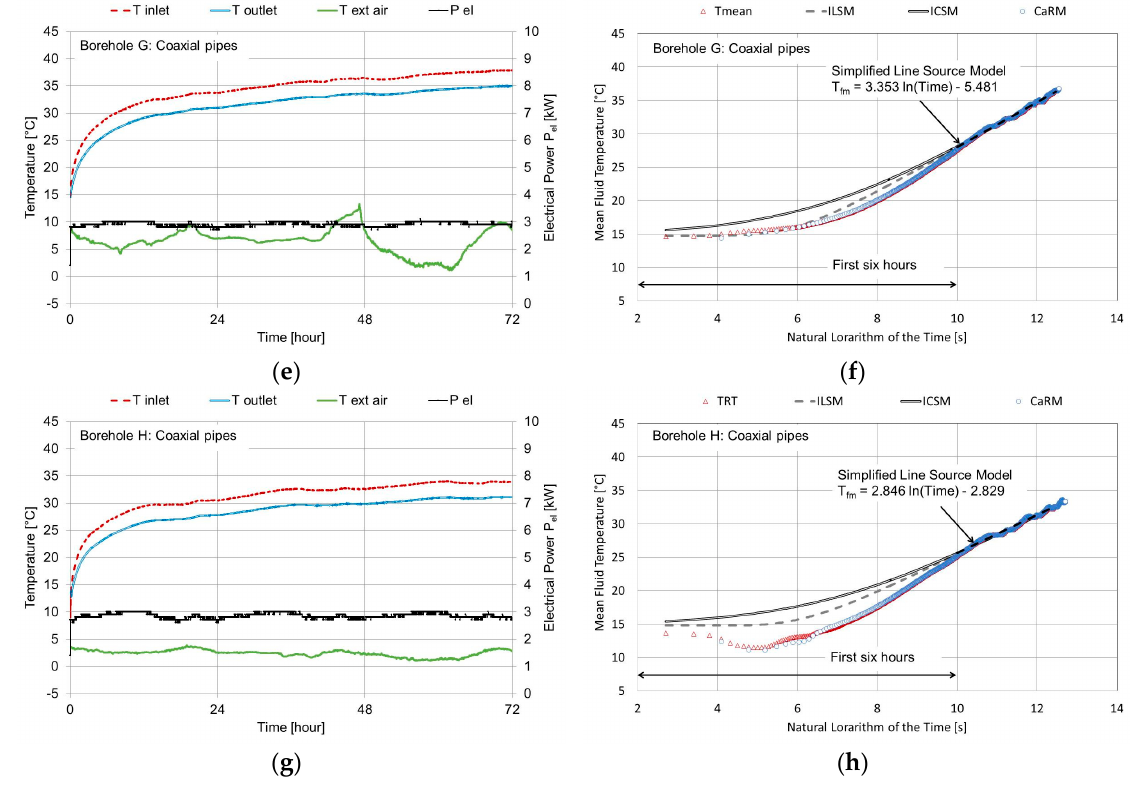
Figure 5. Thermal response test of Boreholes C, F, G and H which were all 50 m long: ( a , c , e , g ) Test measurements of Boreholes C, F, G and H respectively; ( b , d , f , h ) Analysis with analytical and numerical models of Boreholes C, F, G and H respectively.